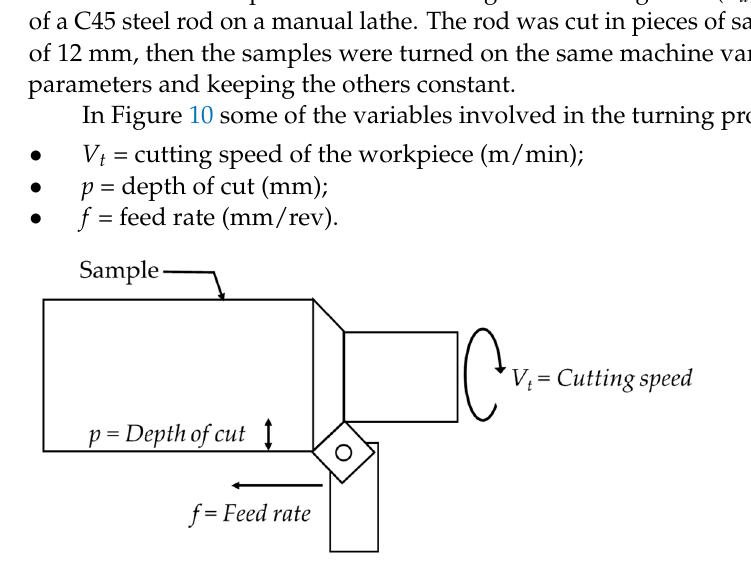
Figure 10. Basic turning parameters.